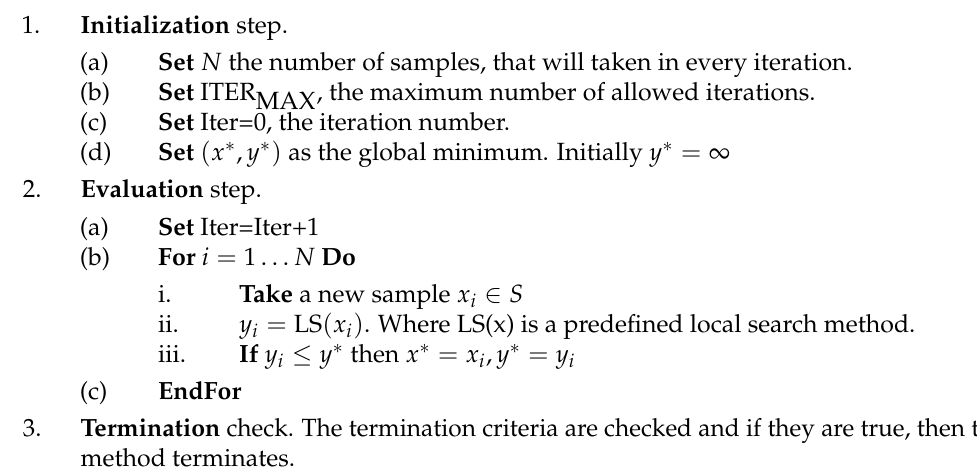
Algorithm 1 Representation of the Multistart